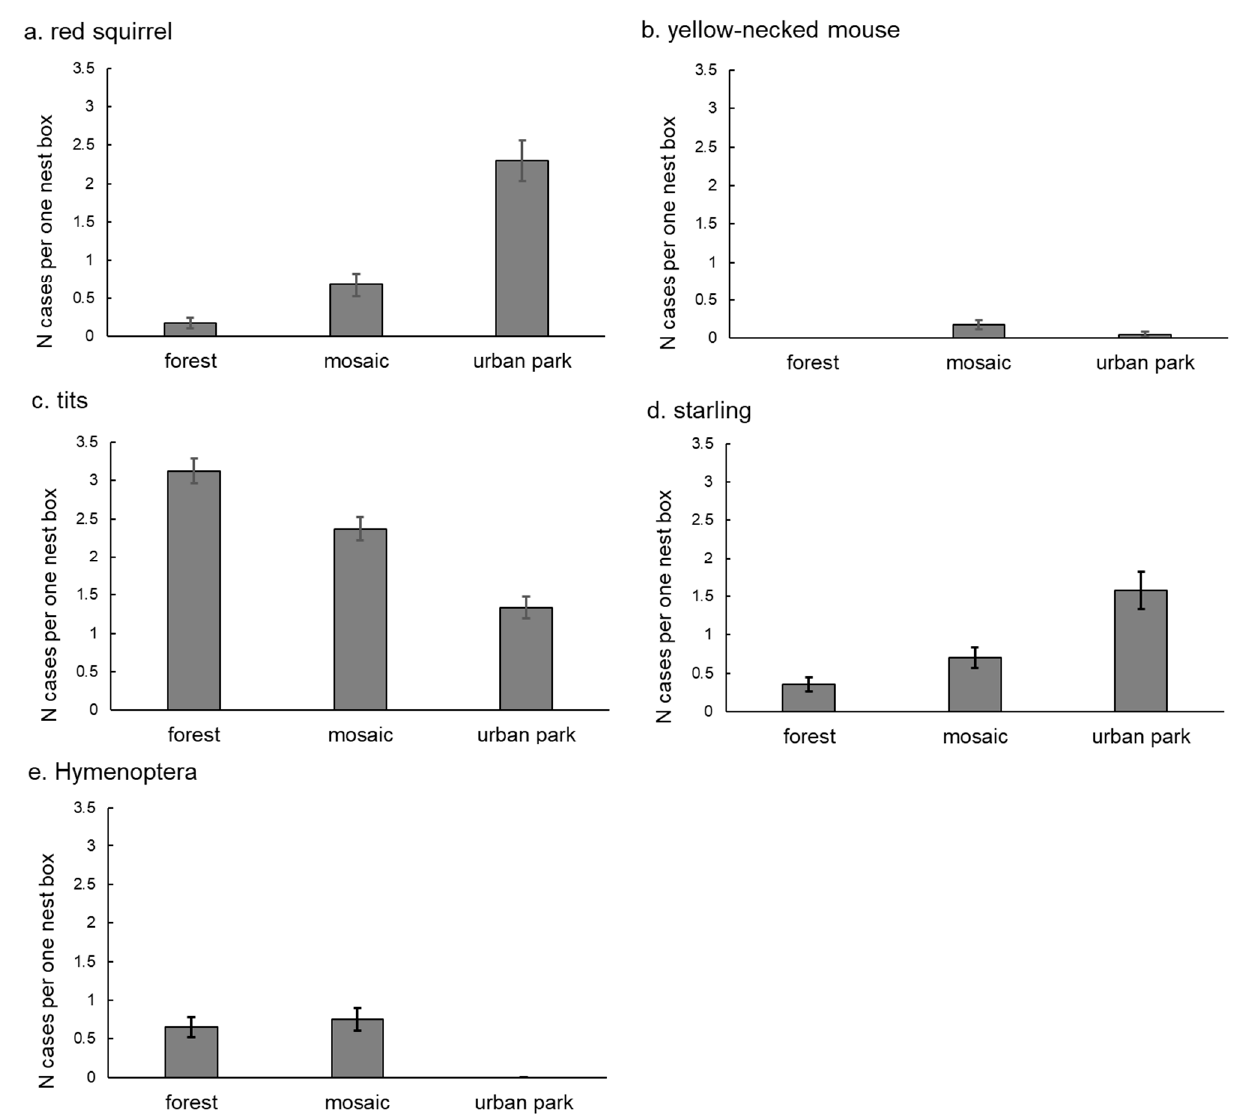
Figure 2. The occupancy of the nest boxes dedicated to the red squirrel (mean ± SE occupancy per one nest box in the 2014–2020 research period) by a target (i.e. red squirrel—figure ( a )) and non-target species/taxa (( b ). yellow-necked mouse, ( c ). tits, ( d ). European starling, ( e ). Hymenoptear) in the three habitats of various anthropopression in central Poland. Each nest box was checked once a year (in winter), and data on records (presence of the nest inside a box) of species/taxa for each nest box from the whole research period were pooled together.